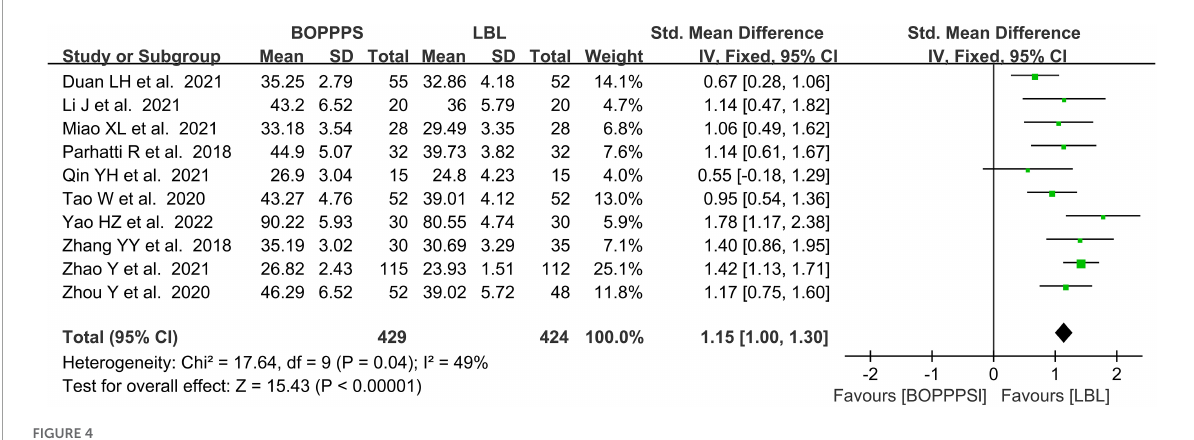
FIGURE4 Forest plot of skill scores for BOPPPS compared with